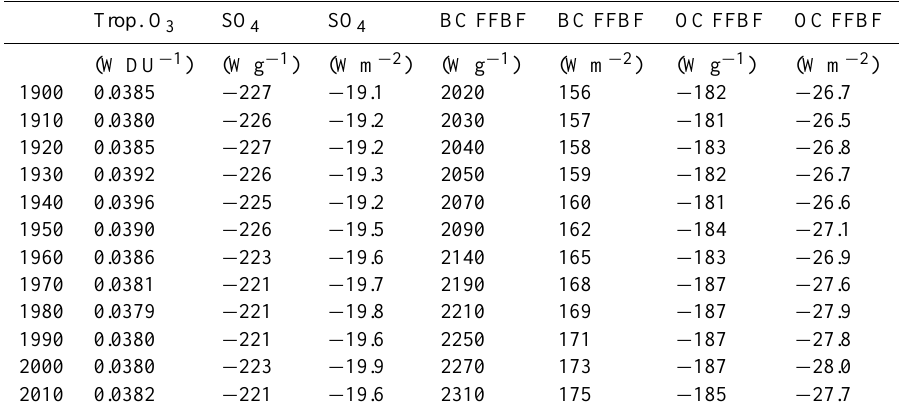
Table 3. Normalized radiative forcing with respect to burden with unit WDU − 1 for ozone and W g − 1 for aerosols and normalized radiative forcing with respect to AOT 550nm with unit Wm − 2